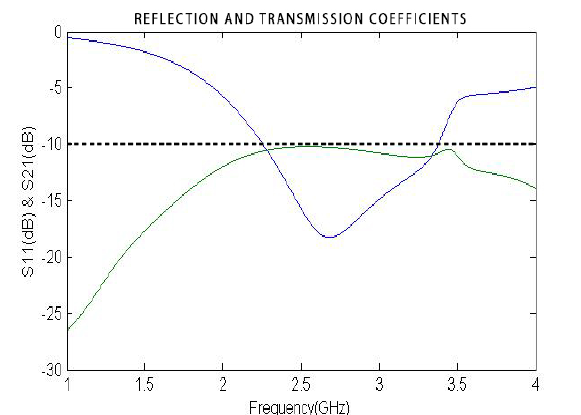
Figure 4: Simulated Reflection and transmission Coefficients of antenna without Split Ring